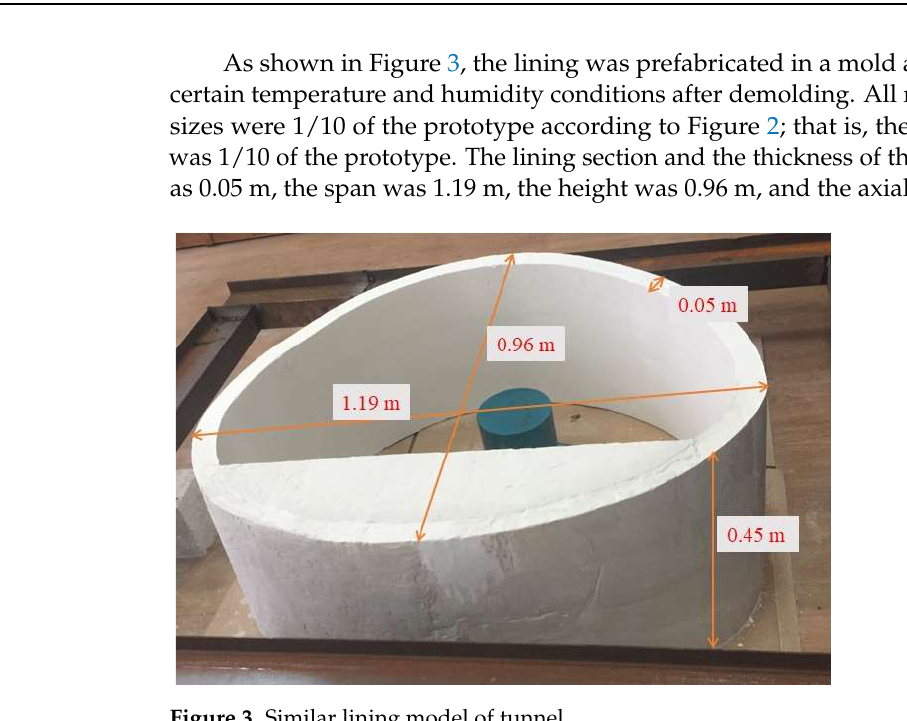
Table 1. Physical and mechanical indicators of lining.